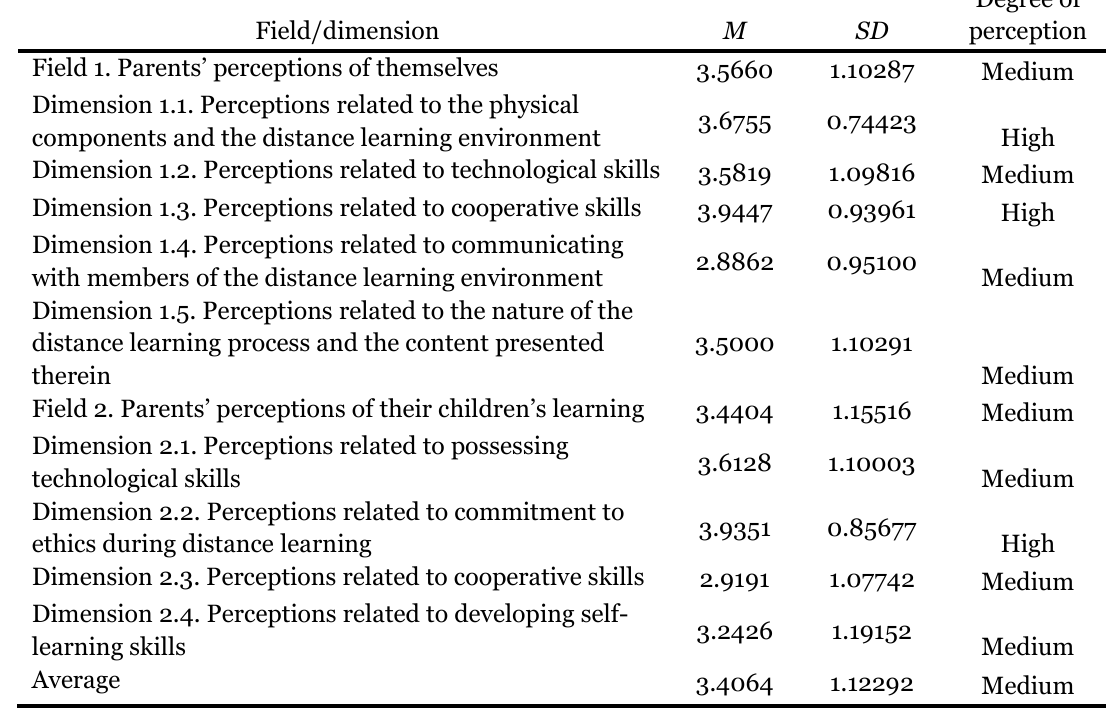
Means and Standard Deviations of Parents’ Perceptions Toward the Distance Learning Process